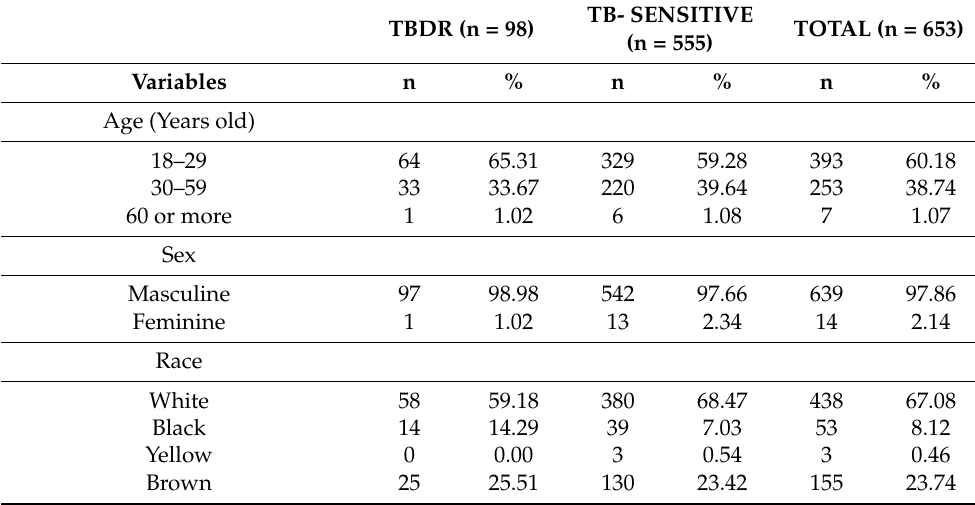
Table 1. Sociodemographic and clinical characterization of tuberculosis cases in the incarcerated population reported between 2008 and 2018 in the State of Paran á ,